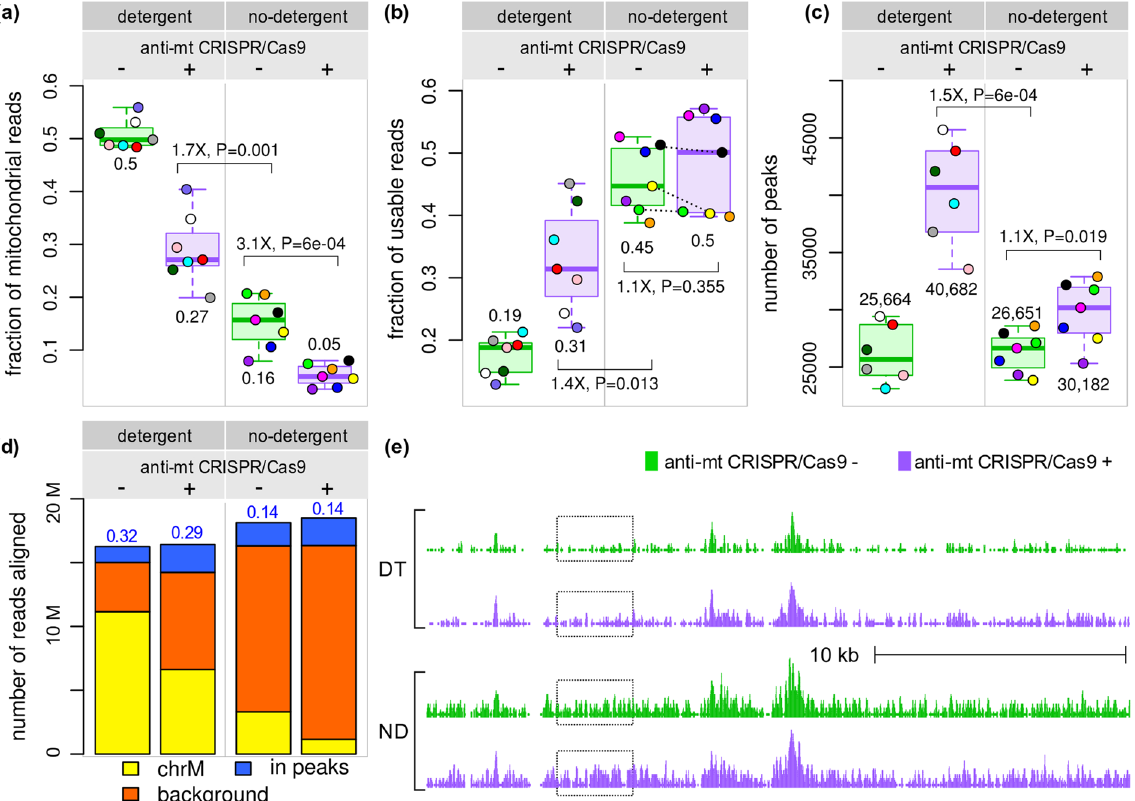
Figure 3. Effect of detergent removal from the ATAC-seq protocol. ( a ) The fraction of mitochondrial reads in samples prepared without detergent was considerably smaller than those prepared with the original protocol. Treatment with anti-mt DNA CRISPR led to further decrease of mitochondrial reads (3.1-fold). ( b ) The fraction of unique, non-mitochondrial reads was considerably higher when detergent was not used. Surprisingly, the anti-mt DNA CRISPR treatment had only a marginal effect on the fraction of usable reads (1.1-fold increase). ( c ) At the same sequencing depth, only 1.1-fold more peaks were called in the ND treated samples. DT samples 18 and 19 were combined as in Fig. 2c. ( d ) ND samples displayed higher background (the number of non- mitochondrial reads outside peaks identified in any DT or ND sample). Numbers in blue above the bars are the ratio between number of reads in peaks and the number of background reads (signal/noise) ( e ) An example illustrating the higher background in ND samples, highlighted by the dashed boxes (chr6:420,146–448,555). Fold-differences calculated on